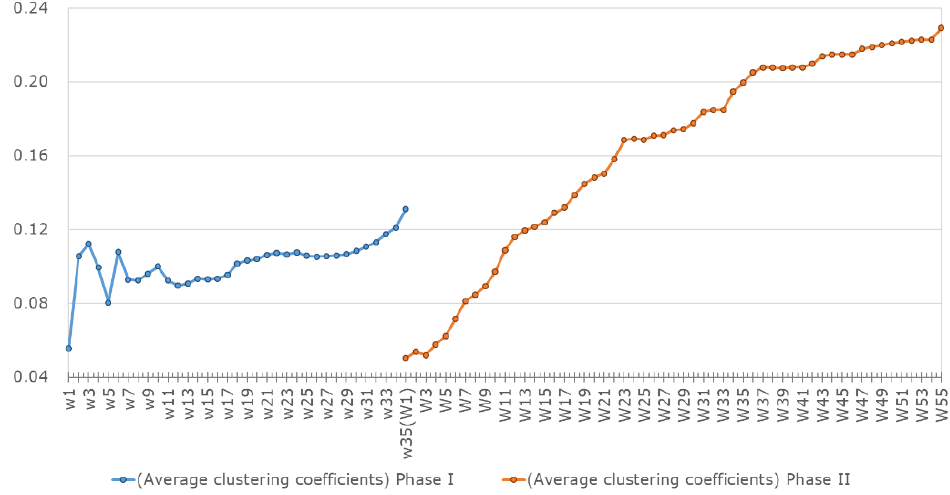
Figure 6. Average clustering coefficient. Note: in the oriental axis, 𝑤 𝑖 and 𝑊 𝑖 are the labels for the time windows of Phase I and Phase II, respectively.